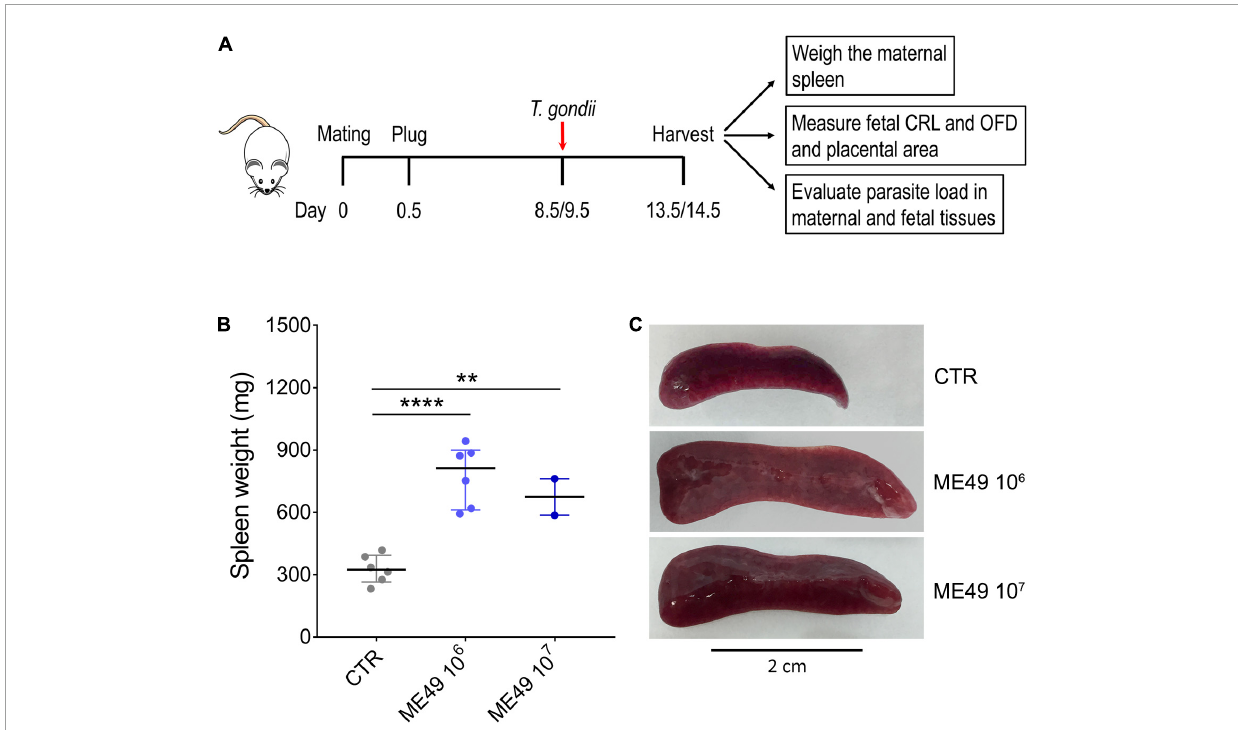
FIGURE1 Splenomegaly induced by systemic T. gondii infection in outbred Swiss Webster mice. (A) Schematic representation of the infection experiment during pregnancy. Pregnant dams were infected intravenously with 10 6 or 10 7 tachyzoites (ME49 strain) at E8.5 or E9.5. The mice were euthanized 5 days later, and fetal and maternal tissues were collected for further analysis. CRL, crown-to-rump length; OFD, occipital-frontal diameter. (B) The spleen weight of each pregnant dam was evaluated and expressed in mg; n = 2–6. CTR, control uninfected group. Each symbol represents data from individual females. Data are presented as median ± interquartile range. One-way ANOVA with Tukey’s multiple comparisons test was employed. ** p < 0.01; **** p < 0.0001. (C) Representative images of the spleens in each